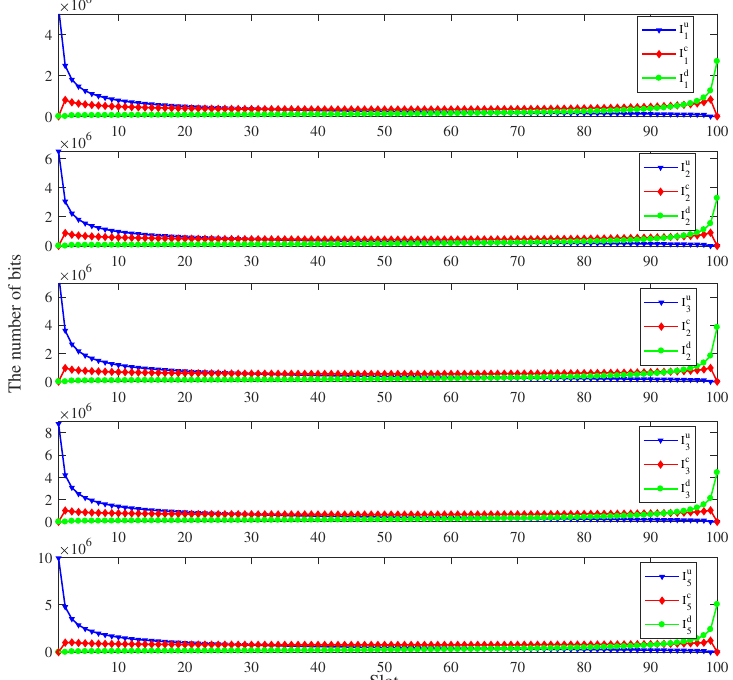
Figure 6. The bits allocation of all users under the time constraint T = 5 s, I 1 = 4 × 10 7 bits, I 2 = 5 × 10 7 bits, I 3 = 6 × 10 7 bits, I 4 = 7 × 10 7 bits and I 5 = 8 × 10 7 bits.